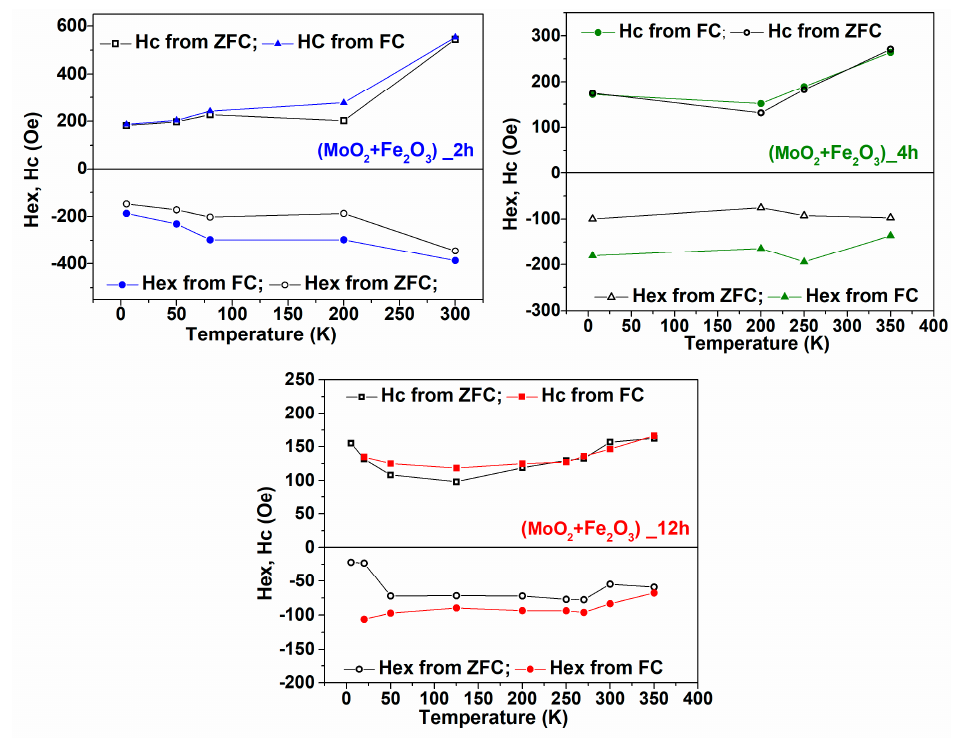
Figure 5. Temperature dependence of the exchange bias field (Hex) and of coercivity (Hc) for samples milled for 2, 4, and 12 h.